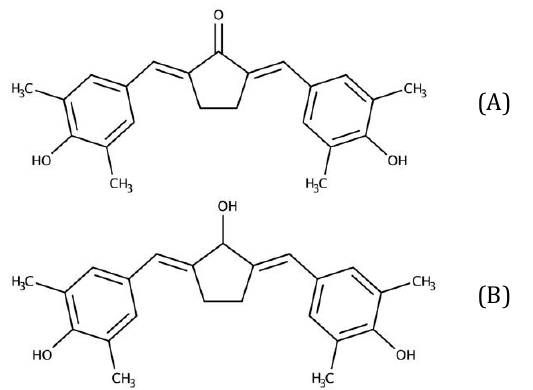
Figure 1. Chemical structures of the compounds of interest. (A) Pentagamavunone-1 (PGV-1; 2,5-bis- (4-hydroxy-3,5-dimethylbenzylidene)- cyclopentanone) and (B) CCA-1.1 (2,5-bis-(4- hydroxy-3,5-dimethylbenzylidene)